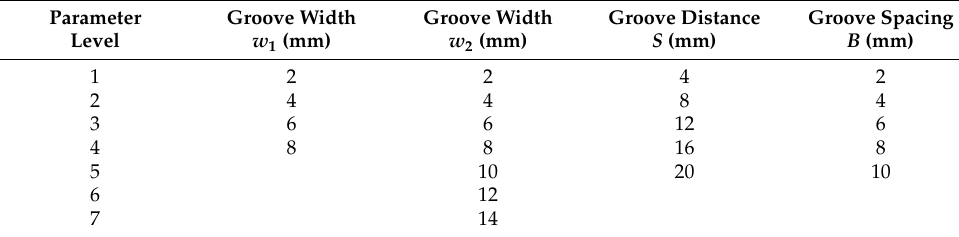
Figure 10. Four schemes for grooving: ( a ) one groove in the cladding layer only; ( b ) one groove in the base layer only; ( c ) one groove in the cladding layer and one groove in the base layer; ( d ) one groove in the cladding layer and two grooves in the base layer. Table 2. Geometry of the grooves .